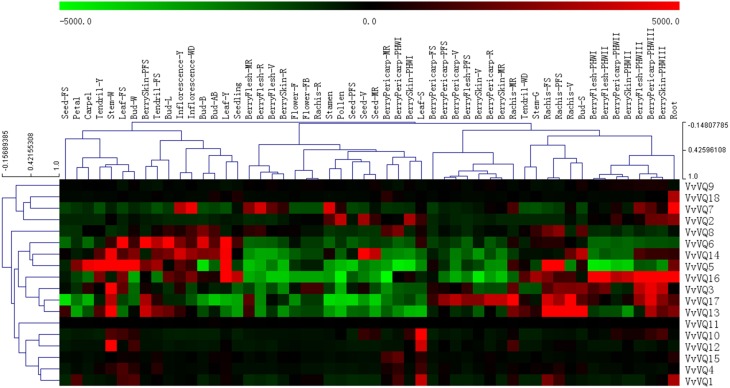
Expression profile of 18 grapevine VQ genes in various tissues and at different developmental stages. Expression data were normalized based on the mean expression value of each gene in all tissues/organs. Different organs/tissues are displayed vertically above each column. Gene names are displayed to the right of each row. Black boxes indicate a low variation with respect to the overall mean value of expression, green boxes indicate a fold decrease, and red boxes indicate a fold increase with respect to the mean value. Samples and genes were hierarchically clustered based on the average Pearson's distance. Abbreviations indicating developmental stages are as follows: FS, fruit set; PFS, post fruit set; V, véraison; MR, mid- ripening; R, ripening; Bud-L, latent bud; Bud-W, winter bud; Bud-S, bud swell; Bud-B, Bud burst; Bud-AB, bud after burst; Inflorescence-Y, young inflorescence with single flowers separated; Inflorescence-WD, well developed inflorescence; Flower-FB, flowering begins; Flower-F, flowering; Tendril-Y, young tendril; Tendril-WD, well developed tendril; Tendril-FS, mature tendril; Leaf-Y, young leaf; Leaf-FS, mature leaf; Leaf-S, senescing leaf; Stem-G, green stem; and Stem-W, woody stem.